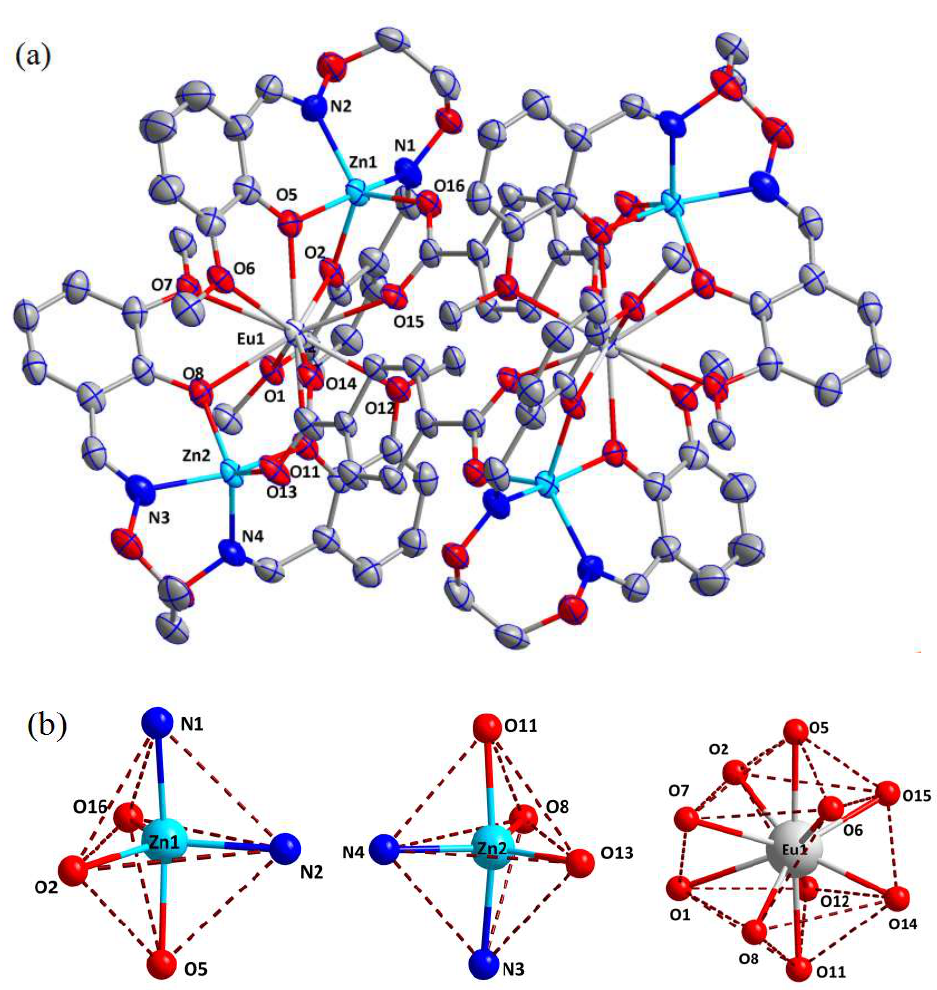
Figure 2. ( a ) Molecular structure and atom numberings of the Zn II –Eu III complex with 30% probability displacement ellipsoids (hydrogen atoms are omitted for clarity); ( b ) coordination polyhedrons for Zn II and Eu III atoms. Table 3. Selected bond lengths (Å) and angles (°) of the Zn II –Eu III complex.